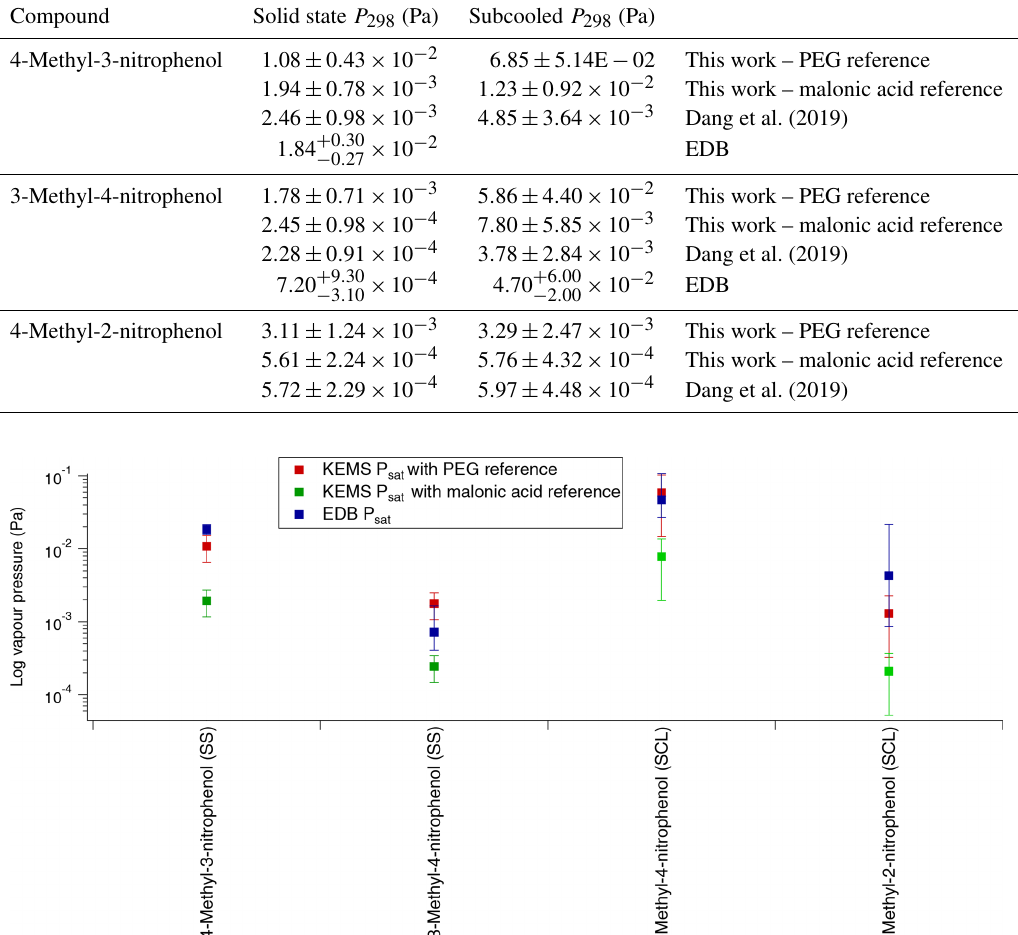
Figure 11. Comparison of P sat between the EDB and the KEMS using both PEGs and malonic acid as the reference compound (SS – solid state, SCL – subcooled